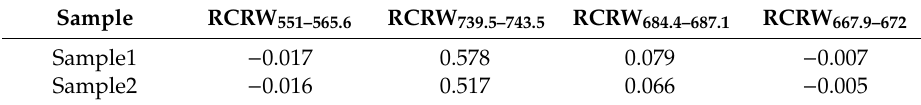
Figure 18. The spectra of Sample1 and Sample2. Table 5. The Four-RCRW a-b values of Sample1 and Sample2.